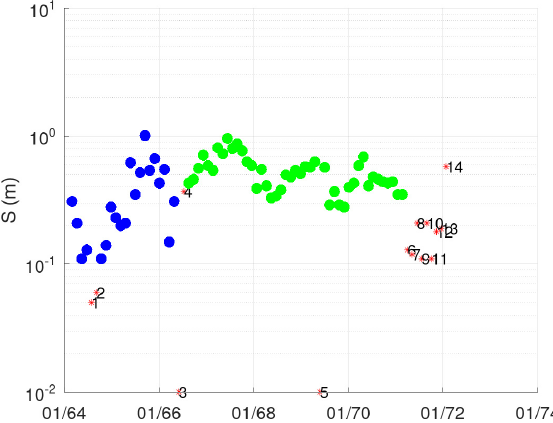
Figure 4. Sakoulevas case study—stage time series plot. With different colours, the partition of DBSCAN. Period 1 (02/1964–04/1966) with blue dots, period 2 (05/1966–01/1972) with green dots, outliers with red stars.